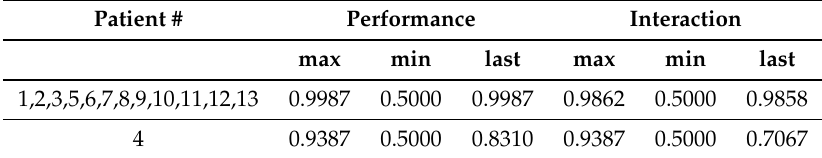
Table 12. Get Up & Go real test results associated to the tests in Table 11 (see text for details).